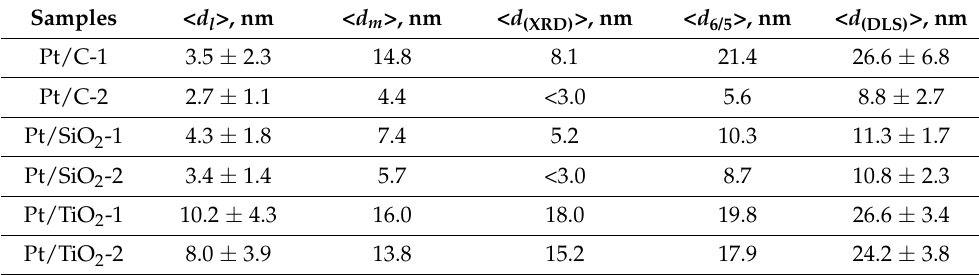
Table 2. TEM and XRD data for supported Pt nanoparticles and DLS data for Pt-contained sols, which are prepared by the STS technique from supported Pt